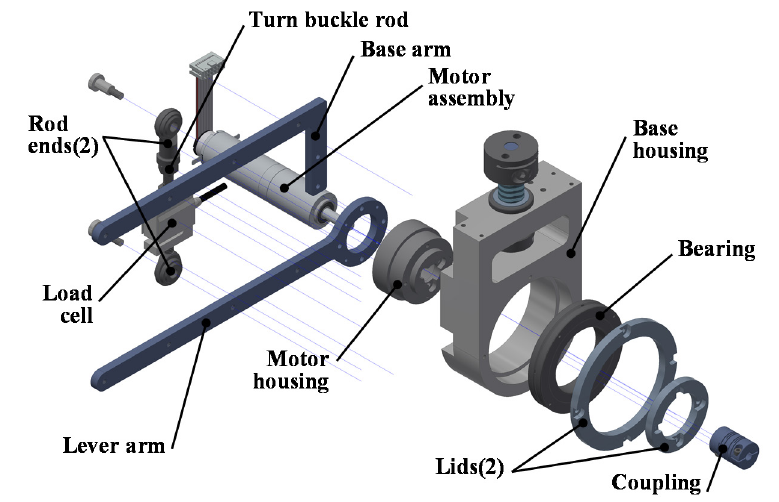
Figure 7. 3D CAD model of the proposed torque sensor. Appl. Sci. 2020 , 10 , x FOR PEER REVIEW